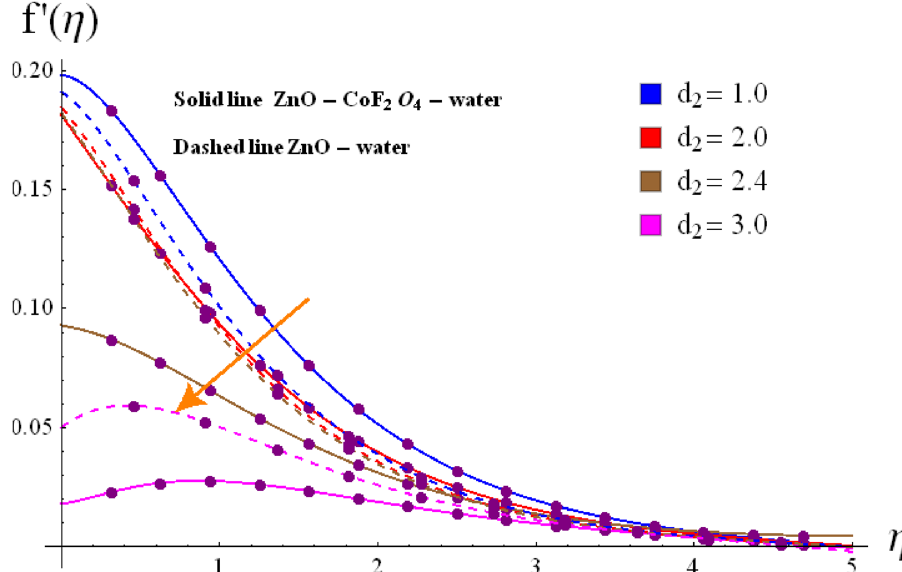
Figure 6. Variation of f ′ (η) via d 2 .